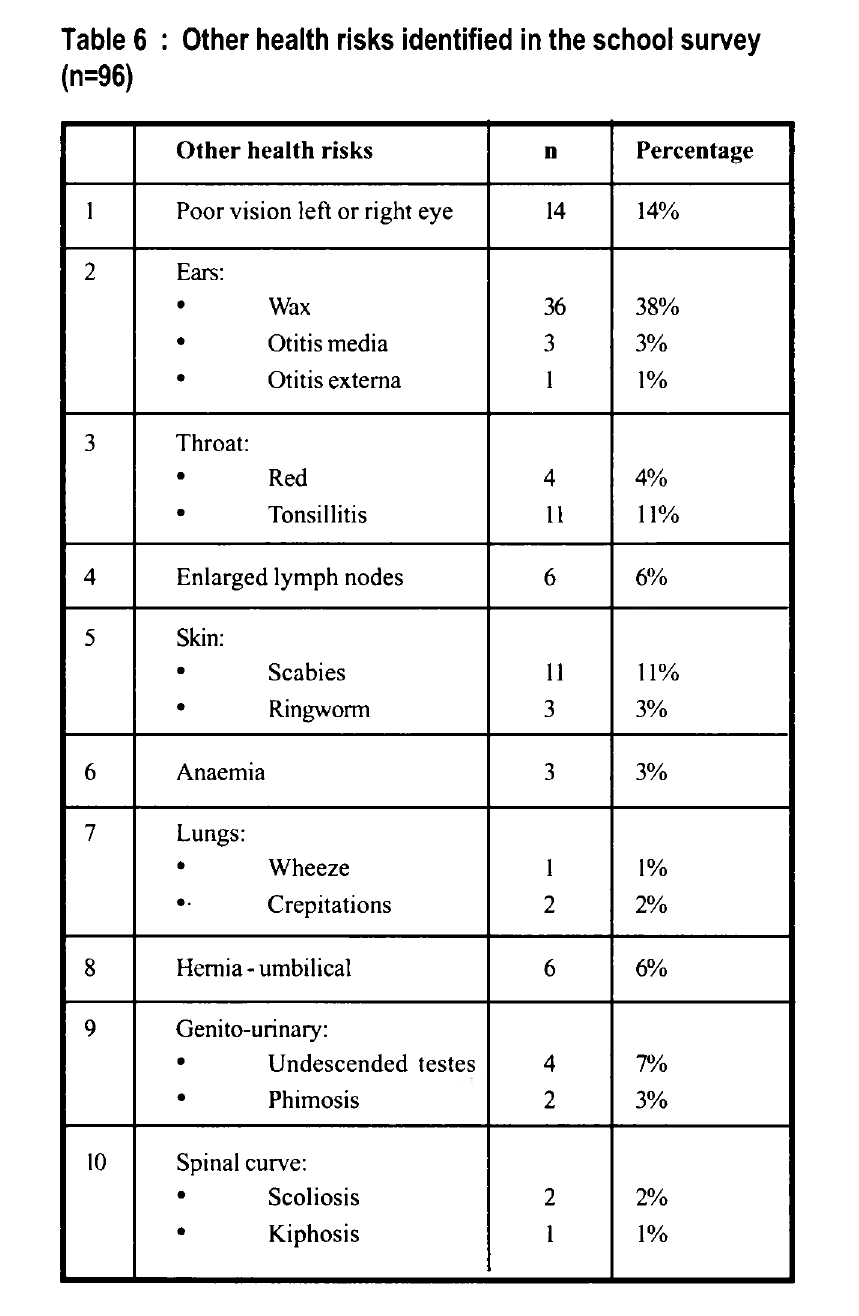
Table 6 : Other health risks identified in the school survey